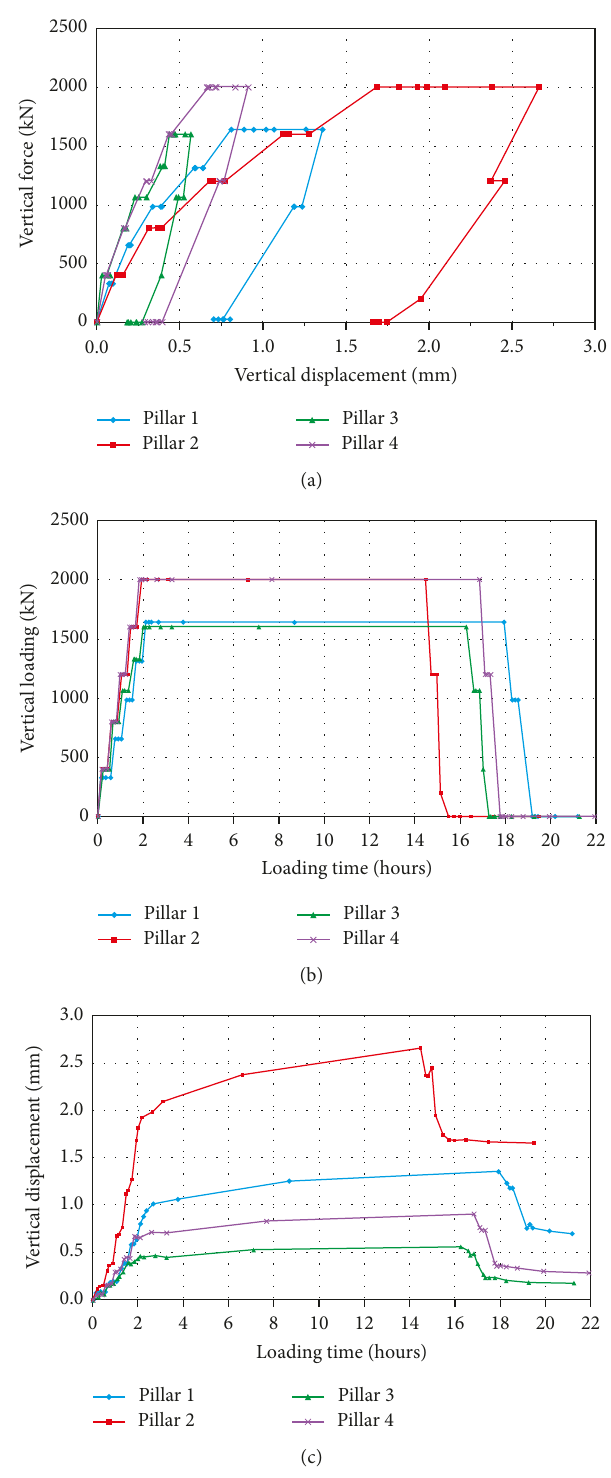
Figure 6: Experimental results on pillar foundations plinths: (a) vertical force versus vertical displacement curves; (b) vertical loading versus time; (c) vertical displacement versus loading